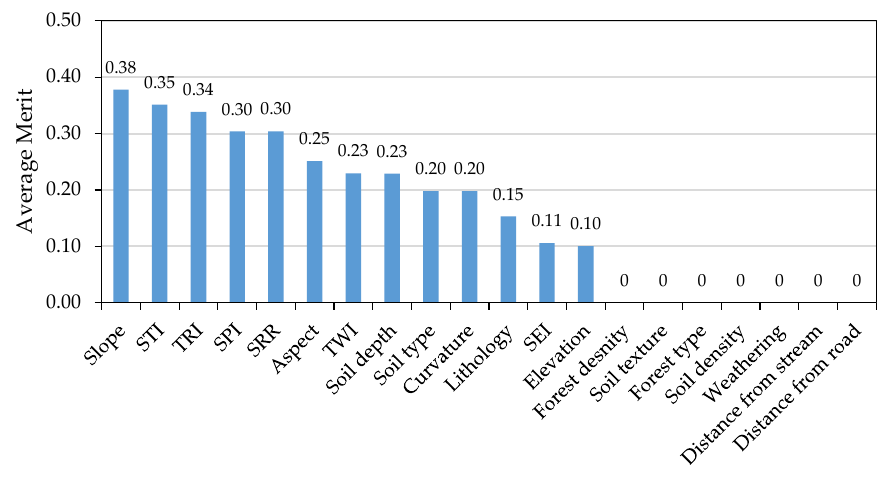
Figure 6. Average merit of the landslide predisposing factors.